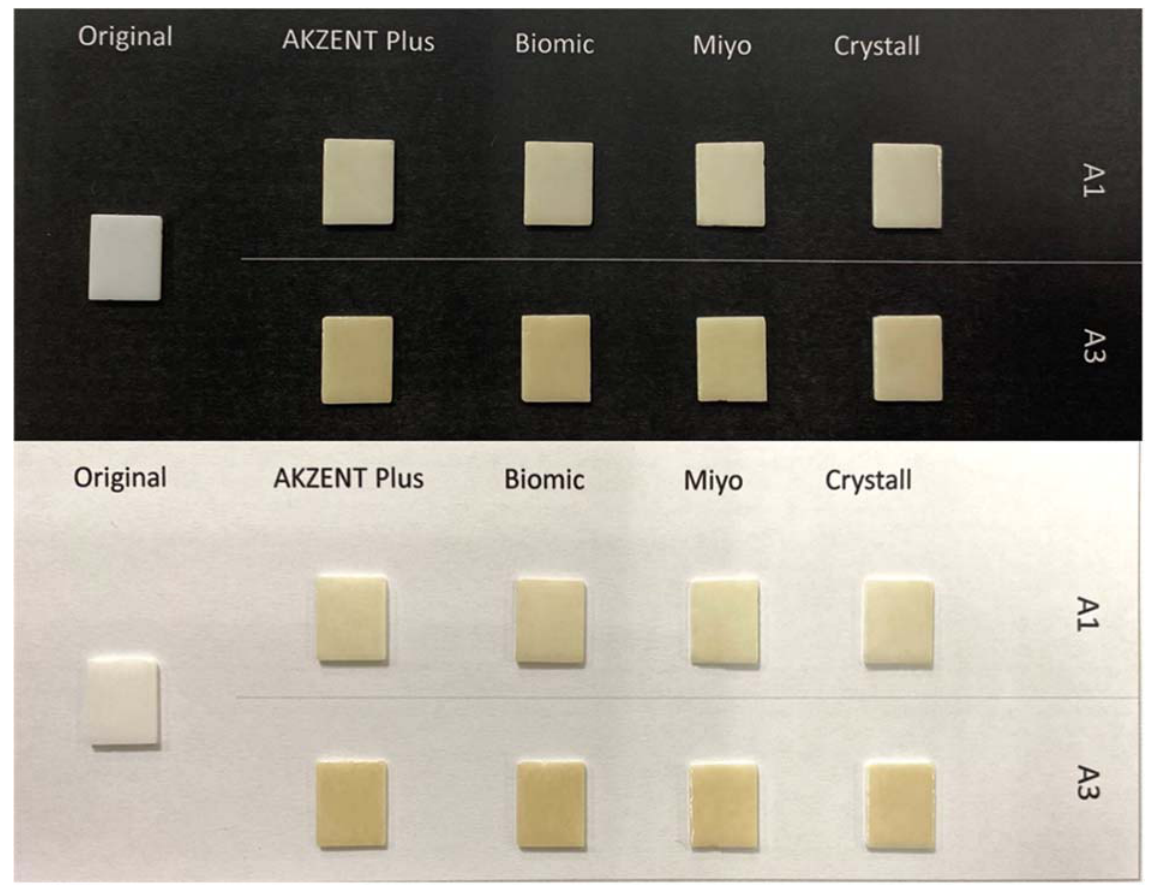
Figure 2. Visual appearance of zirconia samples after staining on black and white backgrounds.